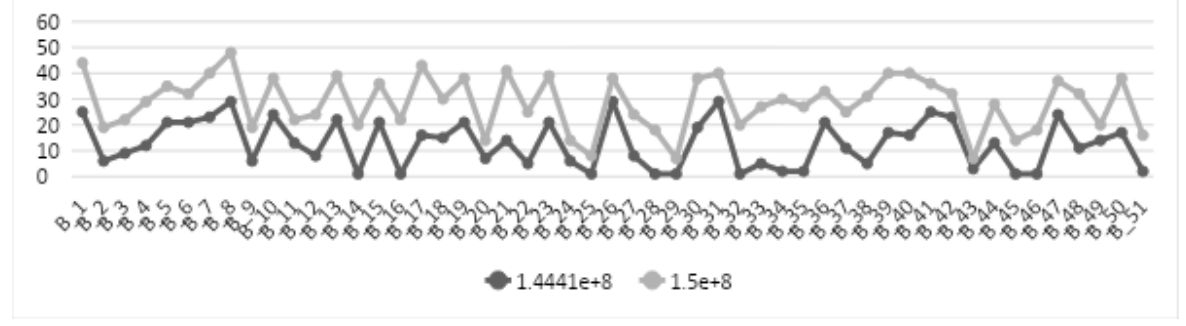
Figure 15- Height changes in the existing and optimized